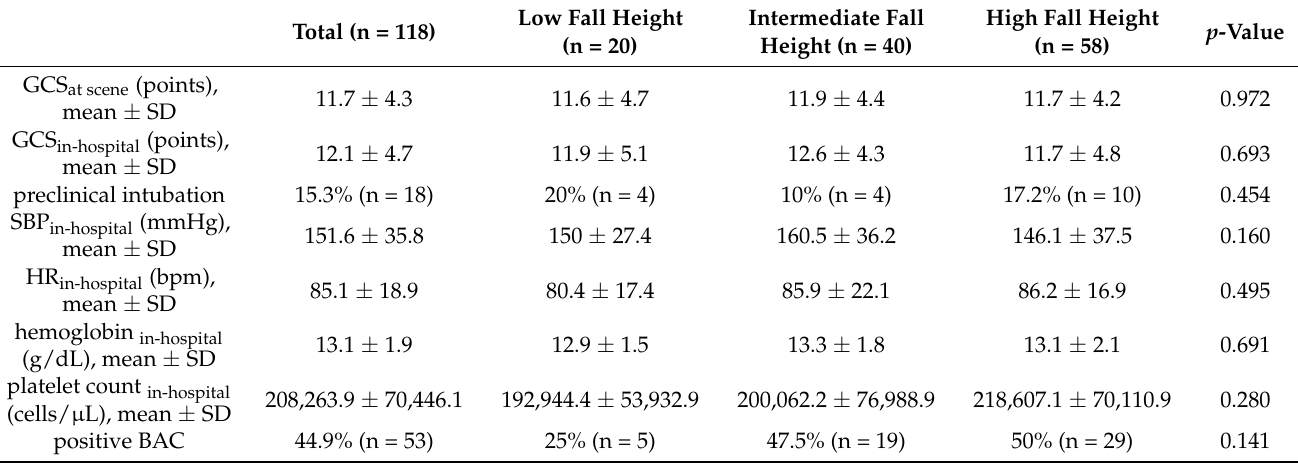
Table 2. Preclinical and clinical parameters.